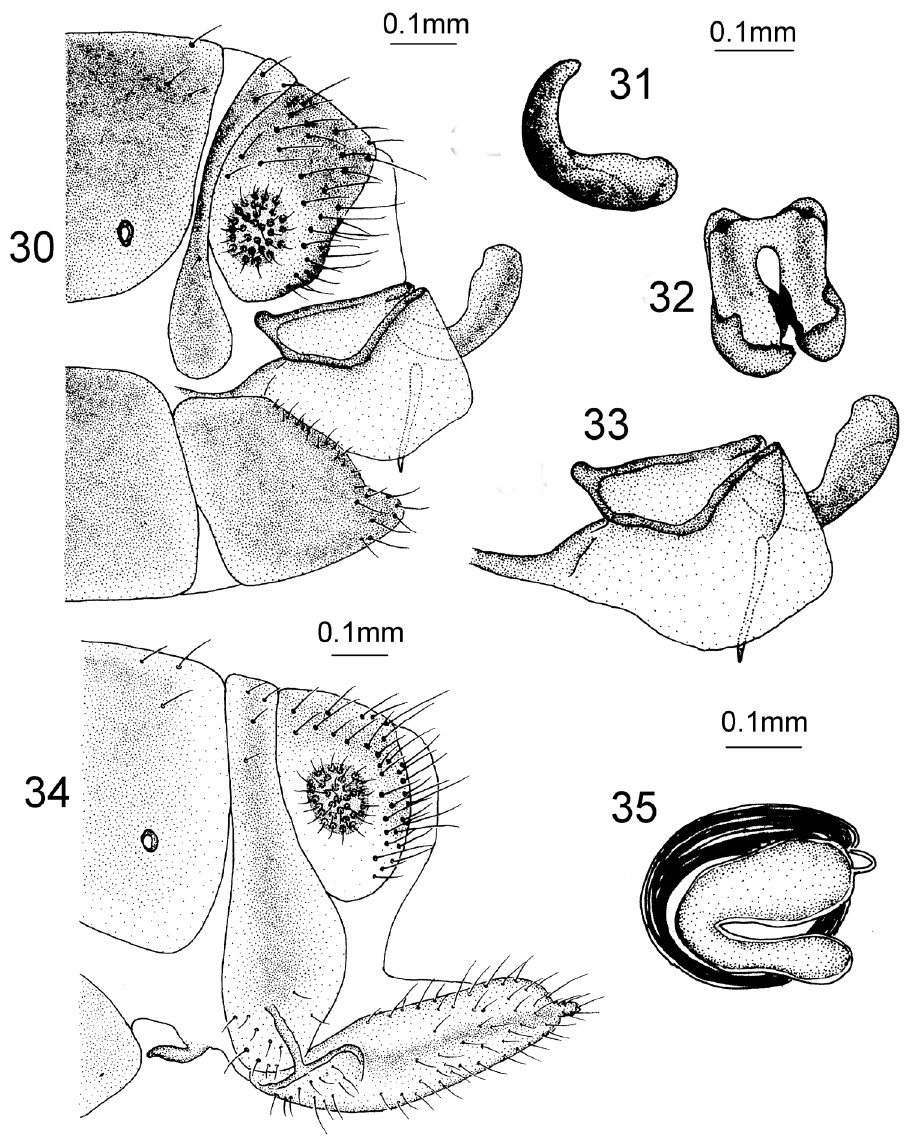
Figures 30–35. Heterosmylus flavidus Yang, 1992. Male. 30 terminalia, lateral view 31 mediuncus, lateral view 32 mediuncus, dorsal view 33 genitalia, lateral view. Female: 34 terminalia, lateral view 35 spermatheca, lateral